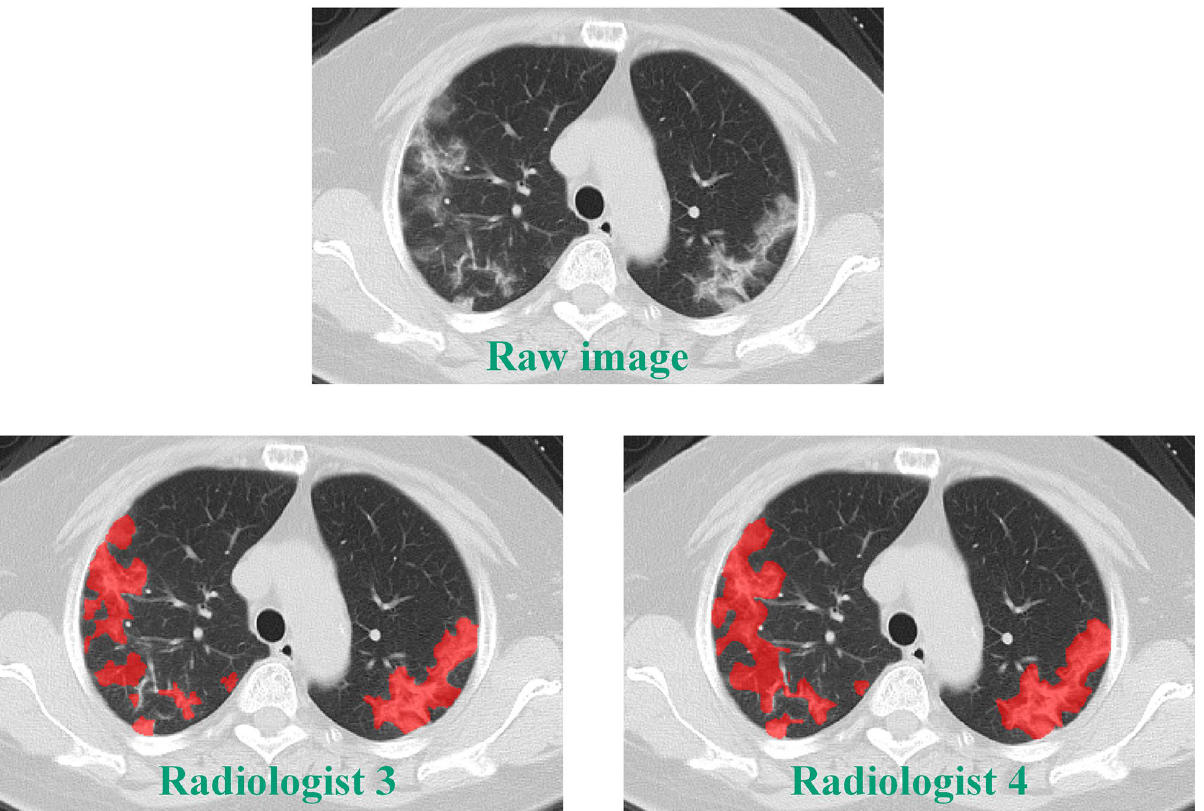
Figure 1. Manual Lesion segmentation by Radiologist 3 and Radiologist 4. This is an example of lesion segmentation in a 68 year old female patient from Site 1. She was assigned to the common type of COVID- 19 patients. The Dice similarity coefficient of the segmented inflammatory lesions between Radiologist 3 and Radiologist 4 is Meanwhile, the quantitative assessment of lung lesions was performed by one of two radiologists (radiologist 3, with 6 years of diagnostic radiology experience; radiologist 4, with 8 years of experience). ITK-SNAP (http:// www.itksn ap.org) was used to manually segment the lung lesions on each slice of CT image along the edge of parenchymal opacification. The lung lesion volume of each patient was the sum of the lesion volume on each CT slice image. In order to confirm the robustness of manual segmentation (Fig. 1), 10 patients were randomly picked out from the whole database and were segmented respectively by these two radiologists. Statistical analysis. The age distribution among each type of patient was compared by using Analysis of Variance (ANOVA), while Chi-square was used to compare the gender distribution. Intra-class correlation coef- ficient (ICC) analysis was conducted to test the assessment reliability of semi-quantitative CT scoring between two radiologists, where ICC < 0.50 means poor reliability, between 0.50 and 0.75 indicates moderate reliabil- ity, between 0.75 and 0.90 means good reliability and > 0.90 means excellent reliability 16 . Dice similarity coef- ficient was calculated for testing the reliability of lesion segmentation between two radiologists, where the value of > 0.70 indicates an excellent agreement 17,18 . In the subsequent inter-group comparisons, a general linear model was performed to detect the differences of CT score and lesion volume between common type and severe type patients with age and gender as covariates. At the individual level, receiver operating characteristic curve (ROC) was computed to test the discriminative efficacy of different methods between common type and severe type patients. Sensitivity, specificity and area under the curve (AUC) were calculated, and the Youden index was used to determine the best discriminative result. P < 0.05 was regarded as statistically significant. In order to clarify the effect of age on the disease severity of NCP patients, we further stratified patients into six groups (Group 1, 21–30 years old; Group 2, 31–40 years old; Group 3, 41–50 years old; Group 4, 51–60 years old; Group 5, 61–70 years old; Group 6, 71–86 years old). ANOVA with Least Significant Difference adjustment was conducted to observe the inter-group lesion load differences that were assessed by the four approaches mentioned above. P < 0.05 was regarded as statistically significant.